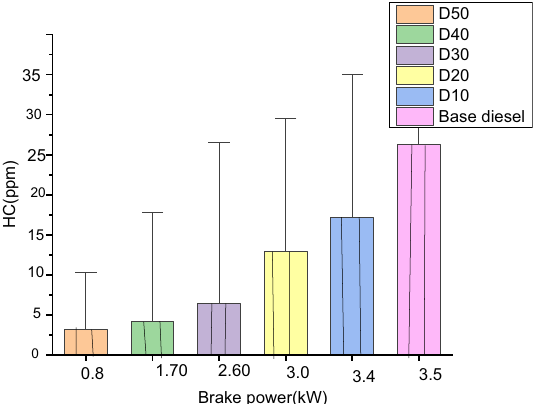
Figure 7. Relationship of unburned hydrocarbon (UBHCs) emissions for different blends.